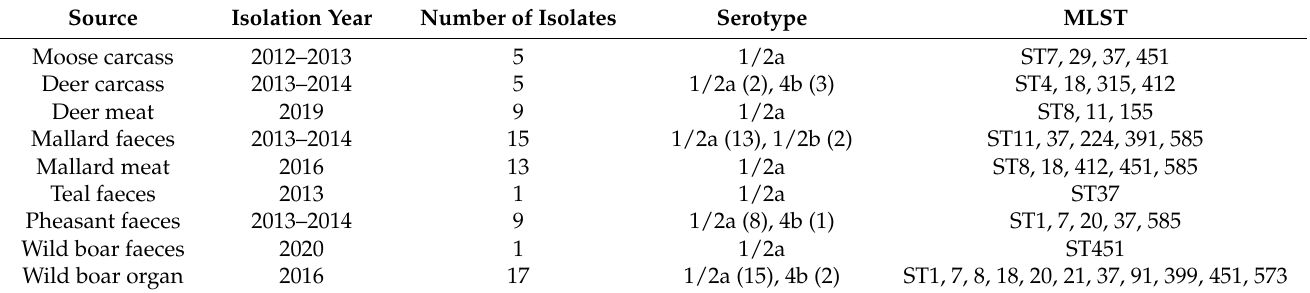
Table 2. Serotypes and sequence type (STs) using 7-gene multi-locus sequence typing (MLST) of 75 Listeria monocytogenes isolates obtained from hunted game and game meat in Finland between 2012 and 2022.